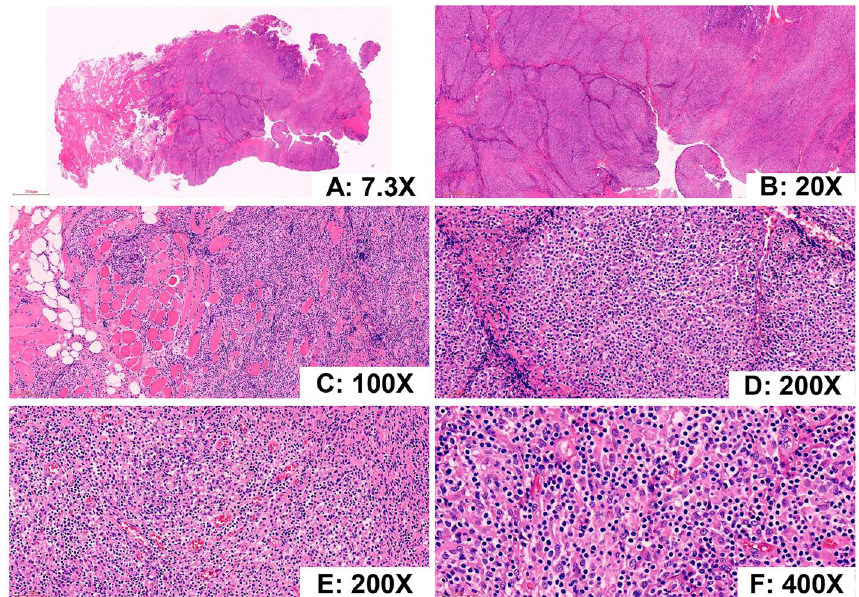
Fig. 2 Microscopic findings (Haematoxylin and eosin [HE] staining). A The demarcation between the lesion and surrounding tissues was unclear and lacked a capsule. B The lesion appeared multinodular in shape. Nodules were surrounded by proliferative fibrous connective tissue. C The tumor invaded the surrounding striated muscle and adipose tissue. D , E The tumor showing a diffuse proliferation of small lymphocytes and numerous large clusters of epithelioid histiocytes. F At high magnification, the proliferation of small lymphocytes displayed slight nuclear irregularities. Plasma cells, eosinophils, and Hodgkin-Reed-Sternberg (HRS) cells were not identified. Rare multinucleated histiocytes were noted, and well-formed granulomas were not present. Rare mitotic figures and no necrosis were observed. (HE staining, A 7.3 200 ; F 400 × ×